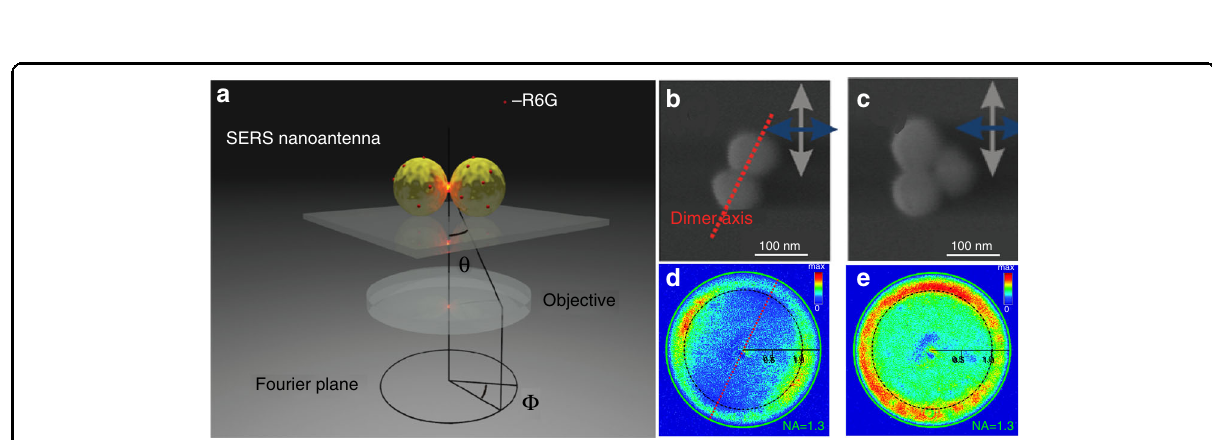
L on the Pt electrode as a